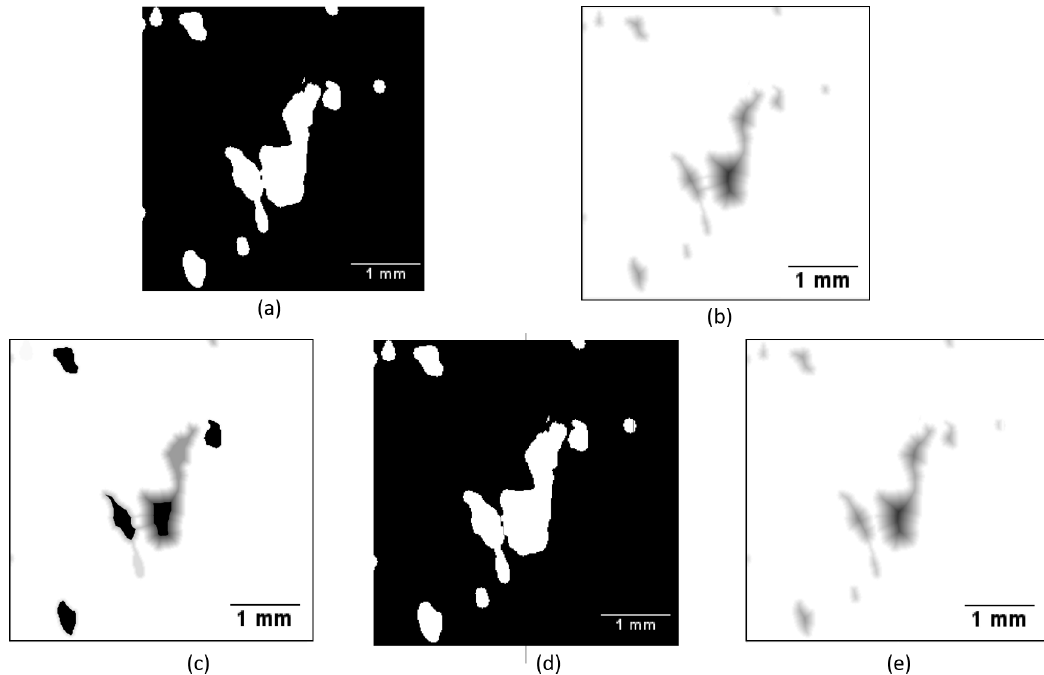
Figure 6. Marker-controlled watershed segmentation process. ( a ) Binary image showing touching grains; ( b ) distance transformation of ( a ), showing two grains are connected with each other; ( c ) Markers are introduced by imposing a minima for each grain; ( d ) watershed segmentation of ( c ), showing a thin ridge is now formed between two grains; and ( e ) the distance transform of ( d ) showing the grains are no longer connected.